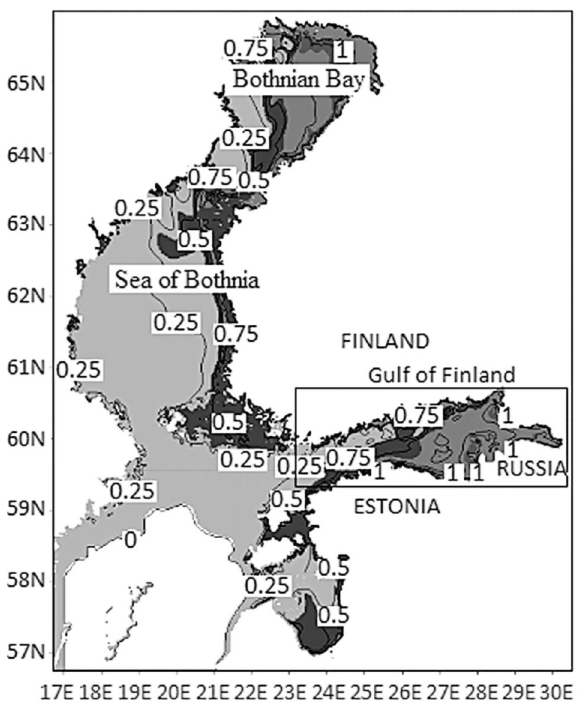
Fig. 1. Baltic Sea. Modelled total ice thickness on 22 February